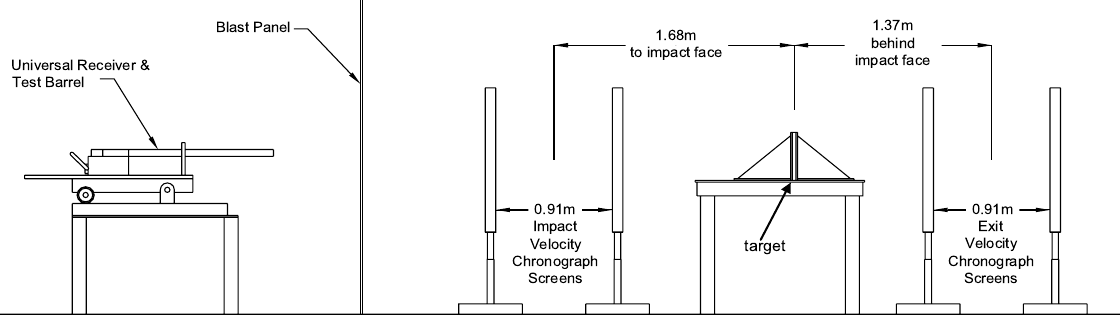
Fig. 4. Schematic of ballistic penetration